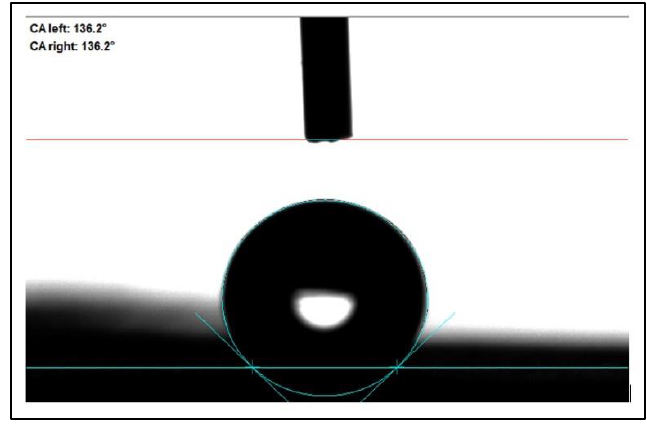
Figure 4. 5 μl water droplet on coated polyester